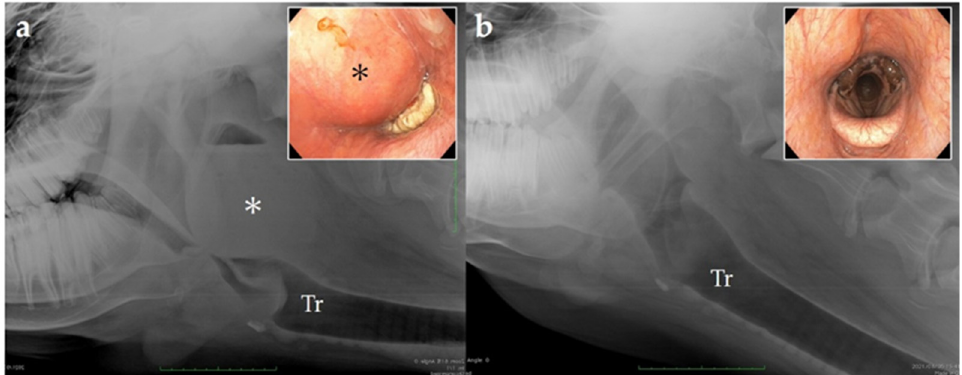
Figure 6. Lateral radiography of the pharyngeal area and endoscopic view via the nasal cavity. ( a ) Day of admission; ( b ) sixteen days after the surgery. Tr: trachea; *: